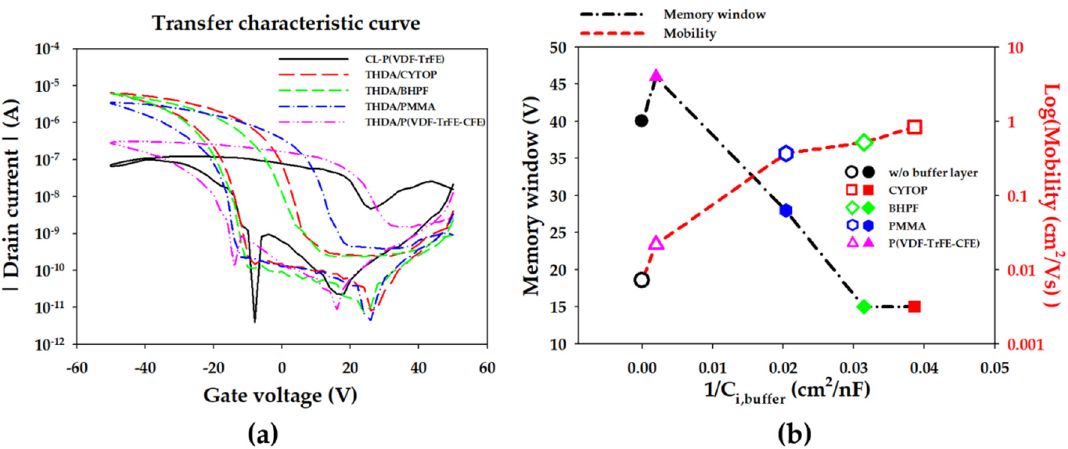
Figure 3. ( a ) Transfer curve of the FeOFETs with and without the buffer layers. ( b ) The memory window and mobility according to the capacitance of the buffer layer.